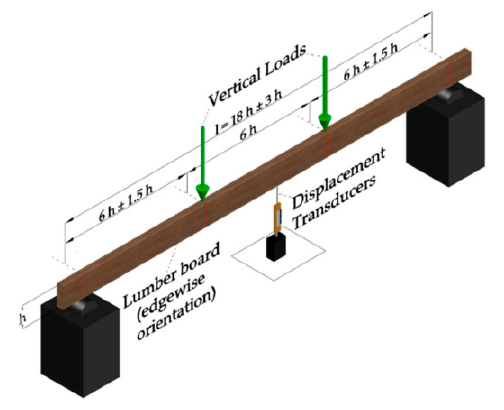
Figure 4. Static bending test set